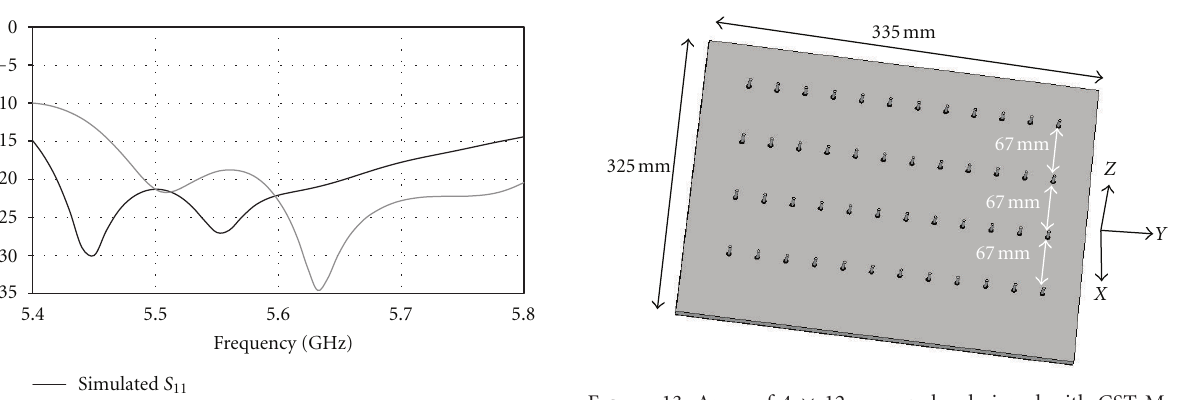
Figure 13: Array of 4 × 12 monopoles designed with CST Mws separated by 0.45 λ 0 along [oy] and 1.25 λ 0 along [ox].